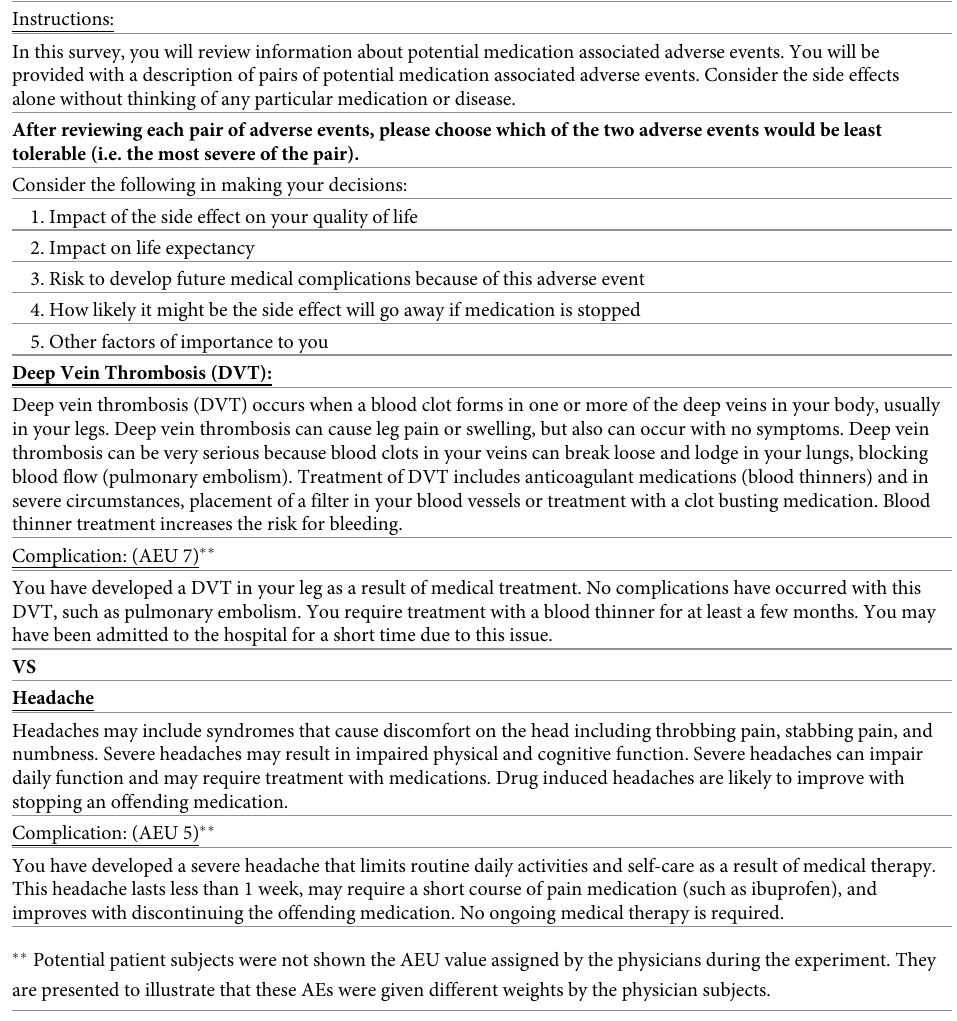
Table 1. Example of potential patient discrete